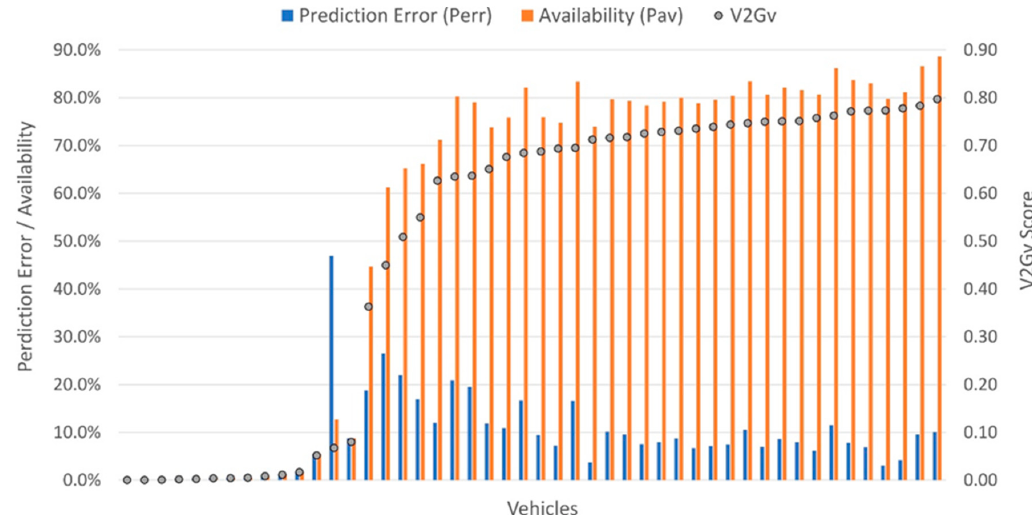
Figure 7. V2G (vehicle-to-grid) viability scores, V2Gv, for the 48 fleet vehicles using the AutoML model on the test dataset.